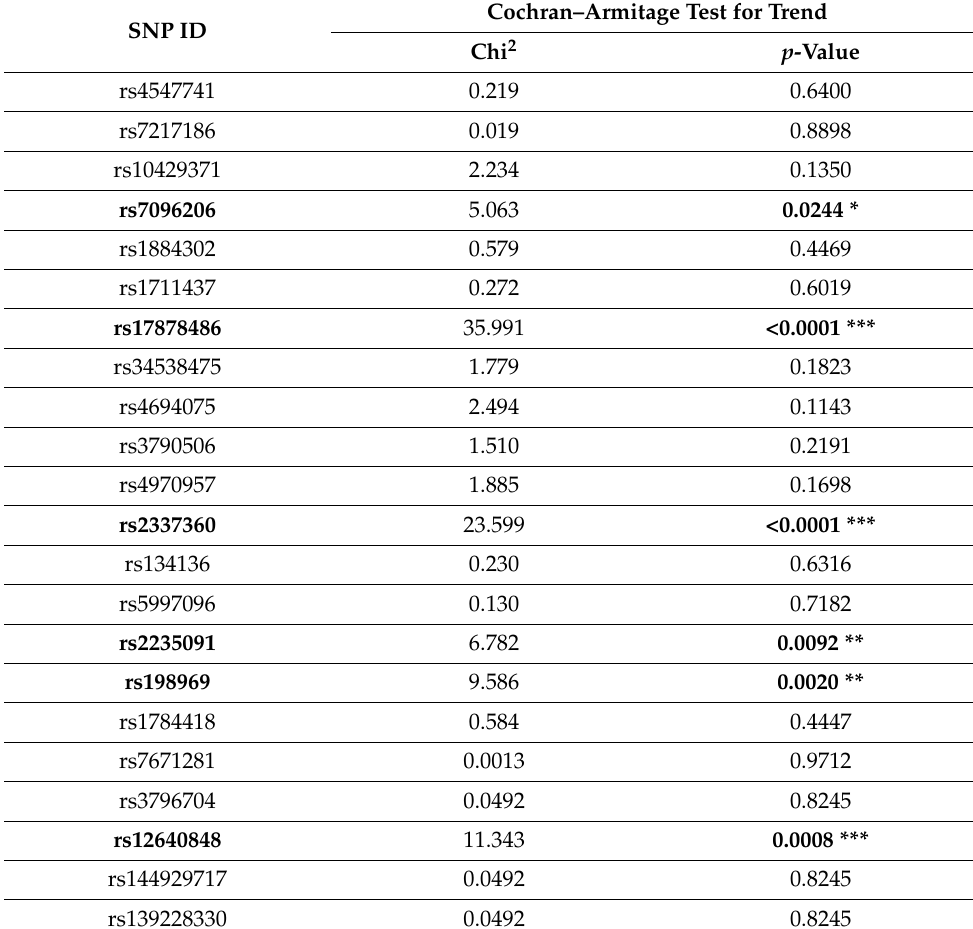
Table 4. Cochran–Armitage test for trend analysis for 22 differentiated single nucleotide polymor- phisms analyzed in this